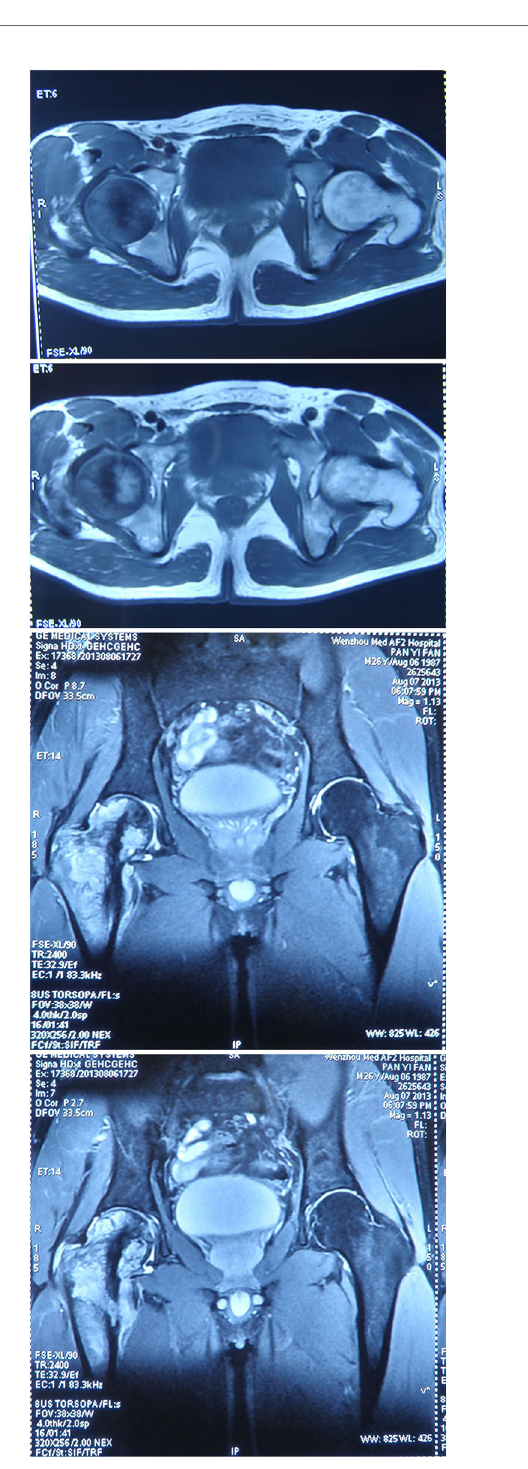
FIGURE 3 | MRI of pelvis at the fi rst week of onset presented a wide range capsule-patterned bone destruction of right femoral head and trochanter with high signal intensity in T2-weight imaging (T2WI) while lower and mixed signal intensity in T1-weight imaging (T1WI). Cortical breakthrough was detected on the anterior of femoral trochanter, and surrounding soft tissue was swelling while acetabulum and joint space was